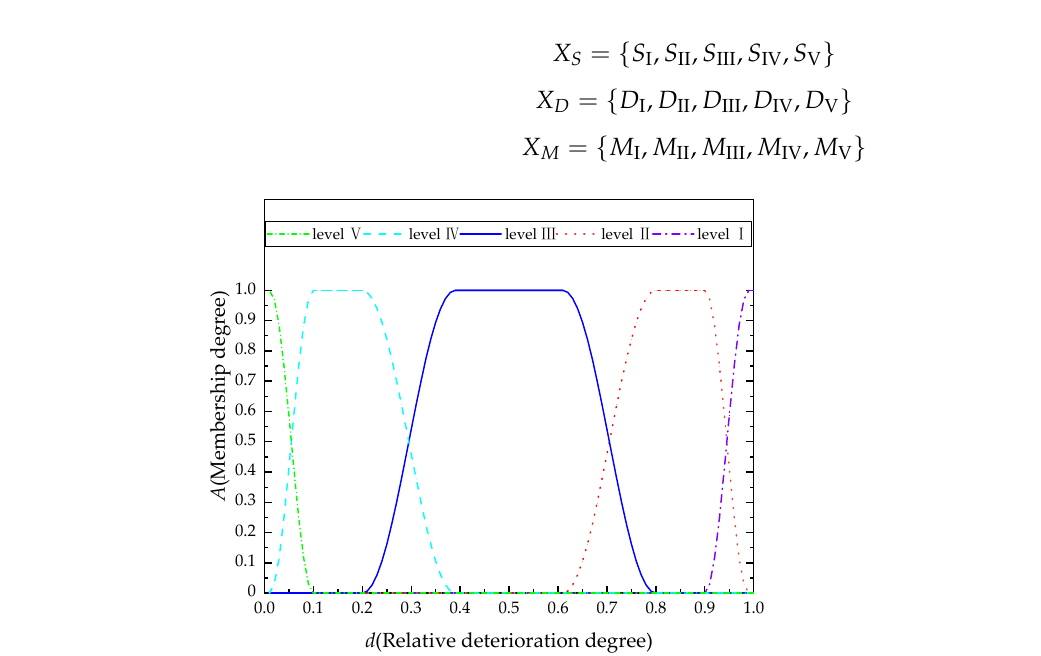
Figure 15. Ridge membership function image (Different colors represent different intervals).